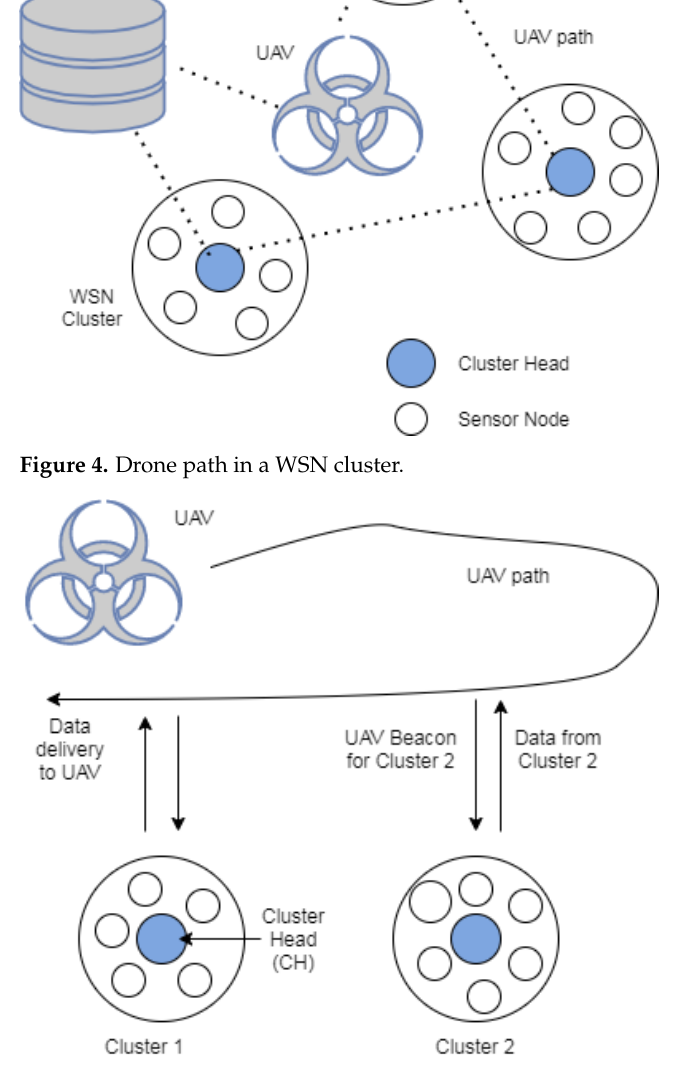
Figure 5. Drone data gathering